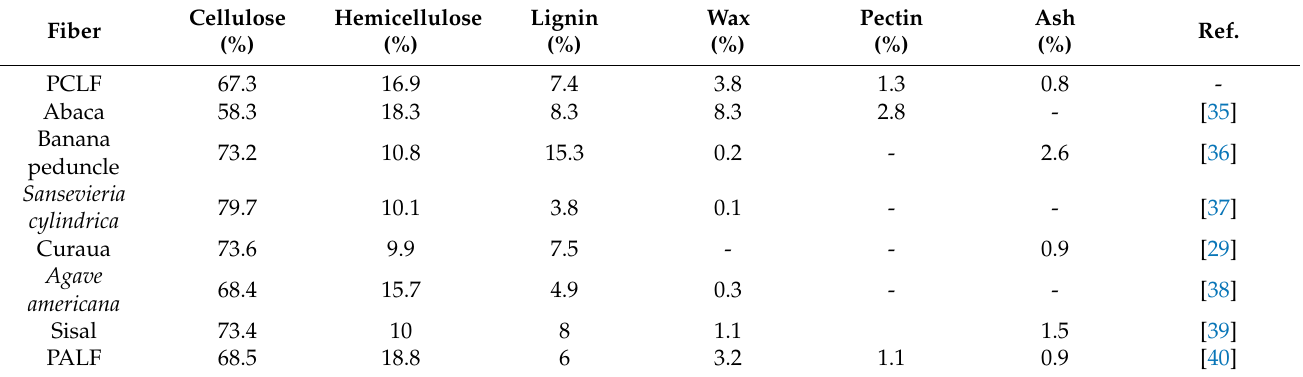
Table 1. Chemical composition of PCLF compared with other fibers of high cellulose